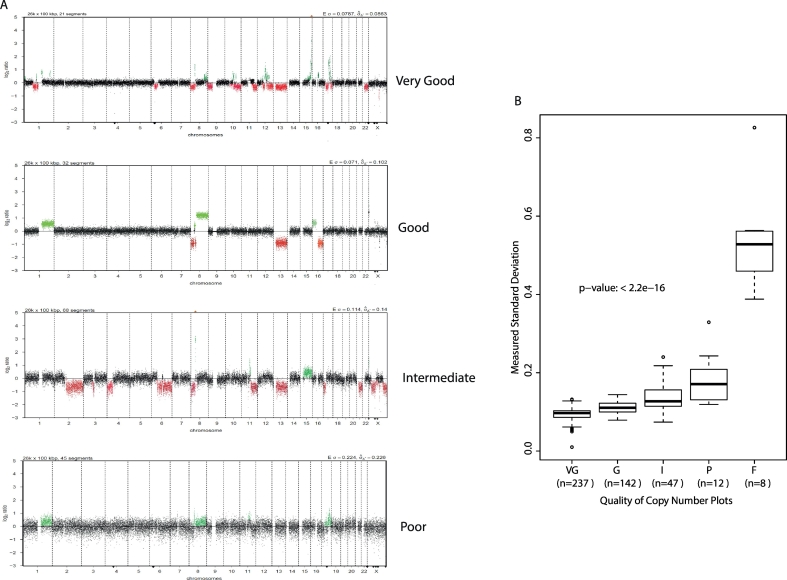
Categorisation of copy number profiles.A. Examples of QDNASEQ copy number plots scored as Very Good, Good, Intermediate and Poor. Failed libraries had very few reads and are not shown. Green dots represent regions of gains/amplifications and red dots represent regions of loss/deletion. B. Boxplots showing increasing measured standard deviations with decreasing libraries'qualities. Dots represent individual samples within each category.VG = very good, G = good, I = intermediate, P = poor, F = fail.